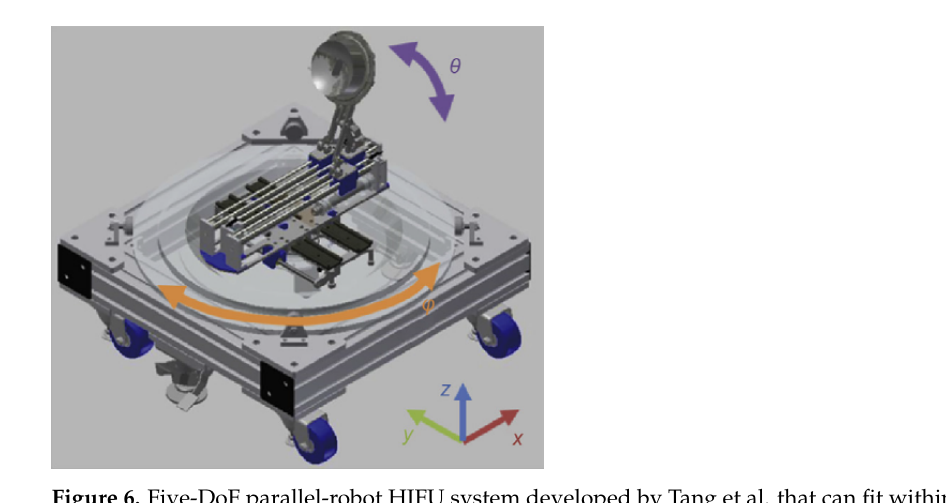
Figure 6. Five-DoF parallel-robot HIFU system developed by Tang et al. that can fit within a water tank beneath the patient table for breast tumor treatment [53]. The motion and axes of this positioning system are